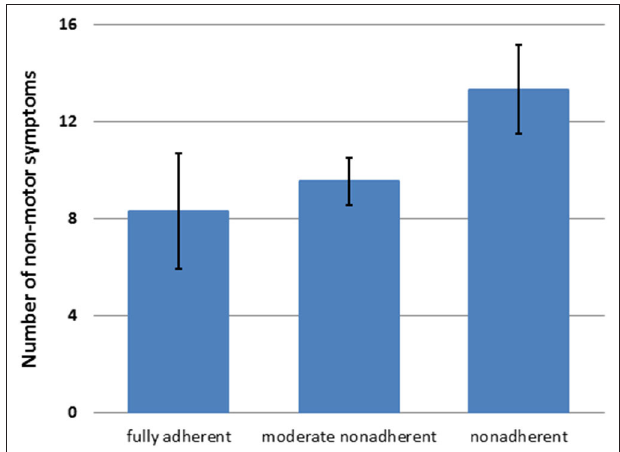
FIGURE 1 | Number of nonmotor symptoms [nonmotor symptoms questionnaire (NMSQ) total score] in patients with different degrees of nonadherence (mean +